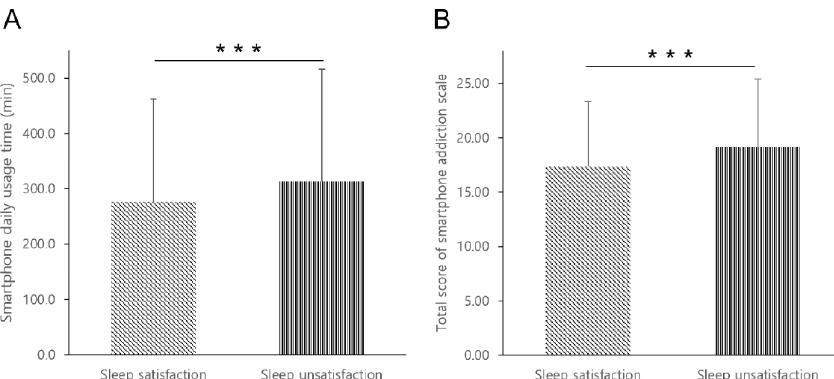
Figure 1. Differences in smartphone usage time and smartphone addiction according to sleep satisfaction: ( A ) daily average smartphone usage time; ( B ) total score on smartphone addiction scale; *** p < 0.001.